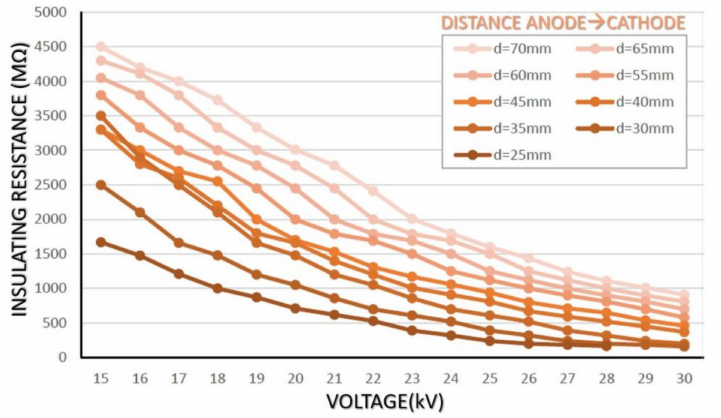
Figure 14. Single thruster: air insulating resistance vs. voltage for different distances between cathode and